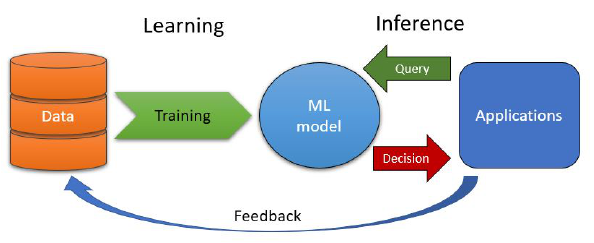
Figure 1. Illustration of the learning